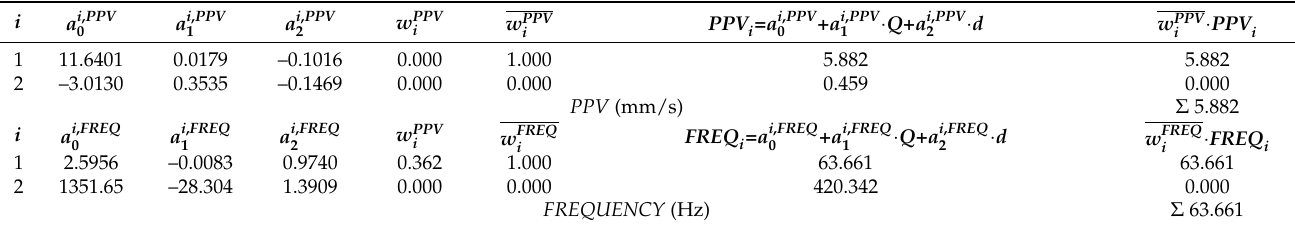
Table 11. Consequent parameters and final outputs for the ANFIS models PPV and FREQUENCY